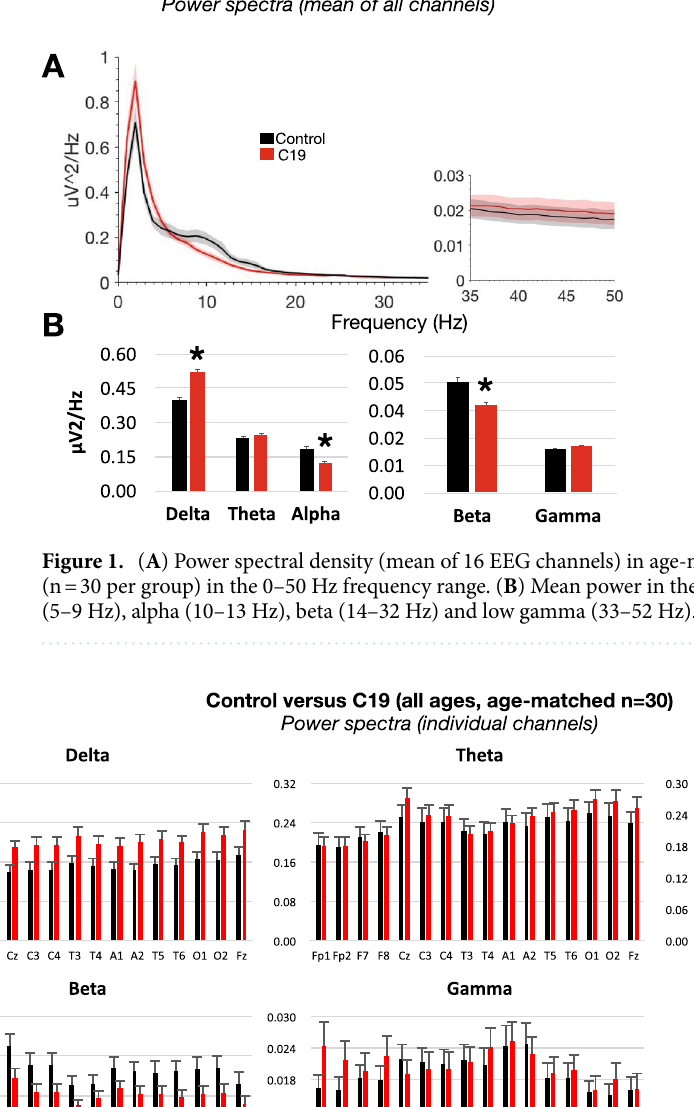
(Table 3), with a mean of 70.5% accuracy in younger subjects compared to a mean of 55.6% for older subjects. These values were obtained using EEG power features selected based on the results of statistical analysis obtained in these groups (for example mean delta, theta, alpha and beta for younger subjects, and theta, beta and gamma for older subjects). Moreover, when the same feature selection used to train a given algorithm in one group was applied to the other group for direct comparisons of accuracy, algorithms for the younger subjects still performed better than those in older ones (77.2% vs. 47.5, and 69.4% vs. 55.6%, respectively).